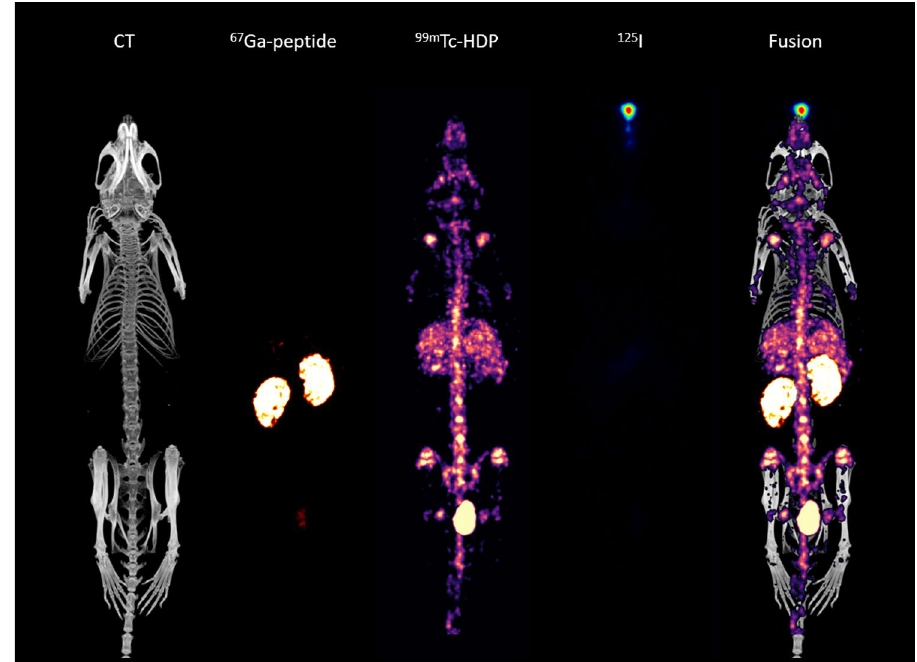
Figure 5. Simultaneous SPECT/CT images obtained for three different tracers labeled with 99m Tc, 67 Ga and 125 I. Separate reconstruction has been obtained for each